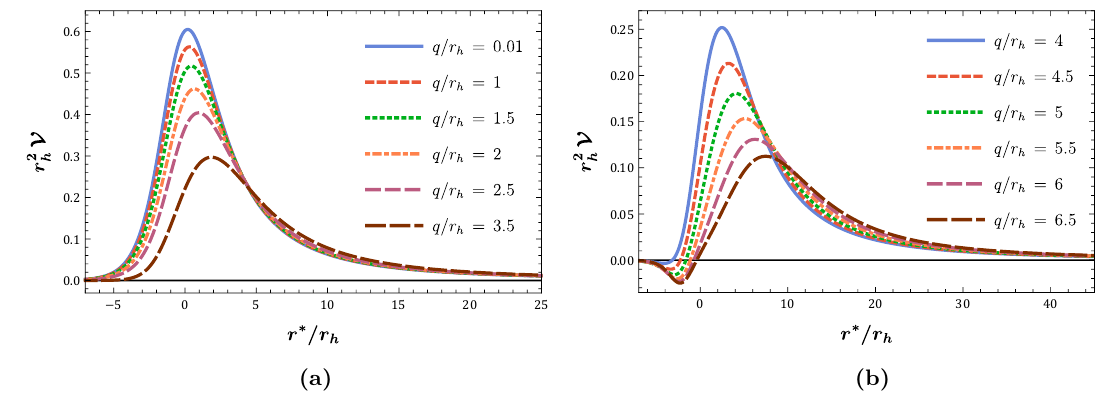
Figure 7. The potential r 2 V in terms of the radial coordinate r ∗ /r h for (a) six stable and h (b) six unstable solutions for different values of the dimensionless parameter q/r momentum L = 2